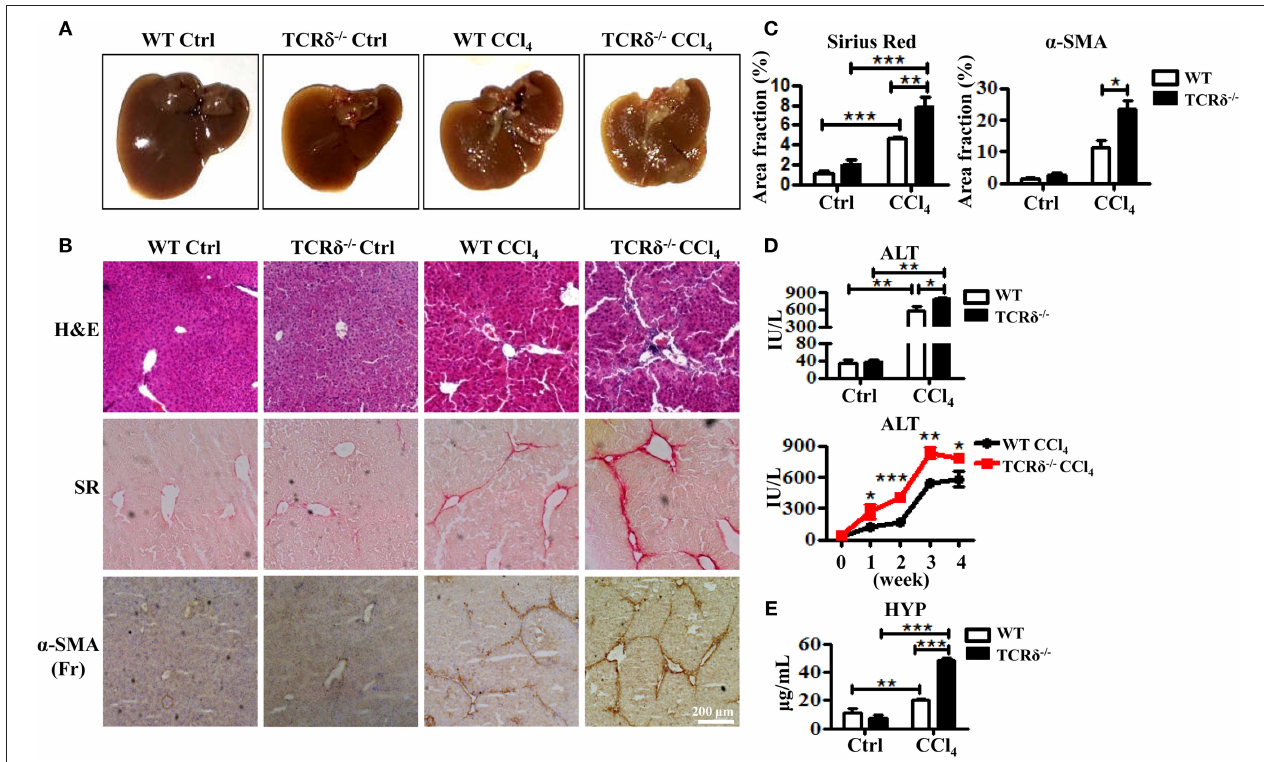
FIGURE 1 | TCR δ − / − mice develop more severe hepatic fibrosis upon chronic liver injury. Liver fibrosis was induced in WT and TCR δ − / − mice by intraperitoneal injection of CCl 4 (0.6 ml/kg) three times per week for 4 weeks. (A) Representative photograph of livers from WT and TCR δ − / − mice treated with CCl 4 or corn oil [control (Ctrl)]. (B) Representative H&E and Sirius Red (SR) staining of frozen liver sections from WT and TCR δ − / − mice, and immunohistochemistry (IHC) for α -SMA in the livers of WT and TCR δ − / − mice. Scale bar: 200 µ m. (C) Quantification of matrix deposition from SR staining (left) and expression of α -SMA (right) as shown in (B) . Data are shown as mean ± SEM ( n = 4). (D) Serum ALT levels in WT and TCR δ − / − mice at 48h after the last CCl 4 injection (top) and at the indicated time points (bottom). (E) Serum hydroxyproline (HYP) contents were measured by ELISA. * P < 0.05, ** P < 0.01, *** P <